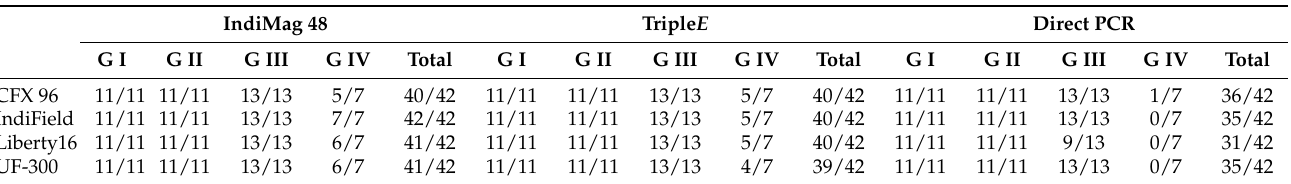
Table 1. Qualitative data analysis of the PCR results representing the different extraction methods and qPCR thermocycler. In each column, the number of positive results related to the total number of tested ASFV-positive samples are presented.